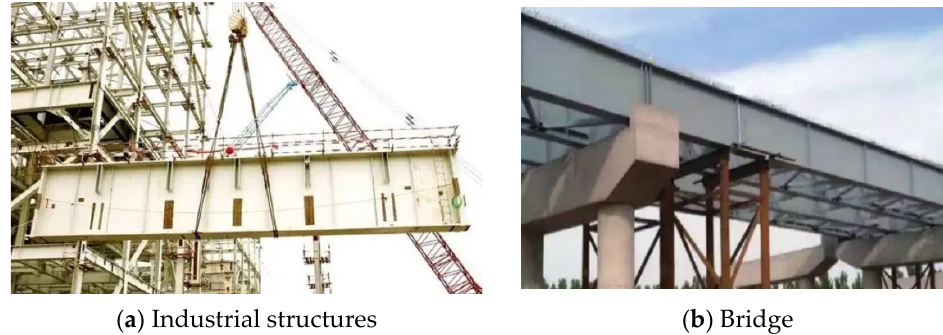
Figure 2. Plate girder engineering